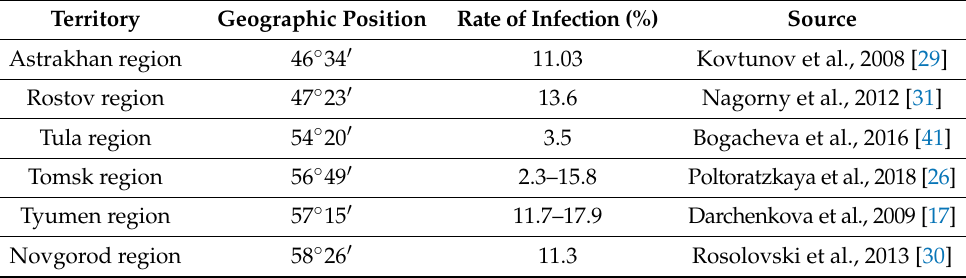
Table 6. Infection rate among Dirofilaria mosquito vectors in various territories of the Russia.